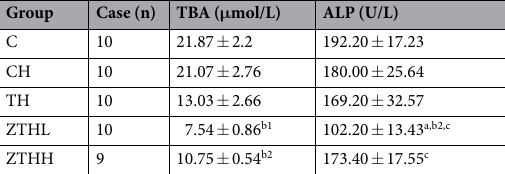
Table 3. Effect of zinc and selenium tea on the serum levels of TBA and ALP in experimental groups (mean and SEM). a Vs C-group, p < 0.01; b vs CH-group, b1 p < 0.01, b2 p < 0.05; c vs TH-group, p < 0.05.